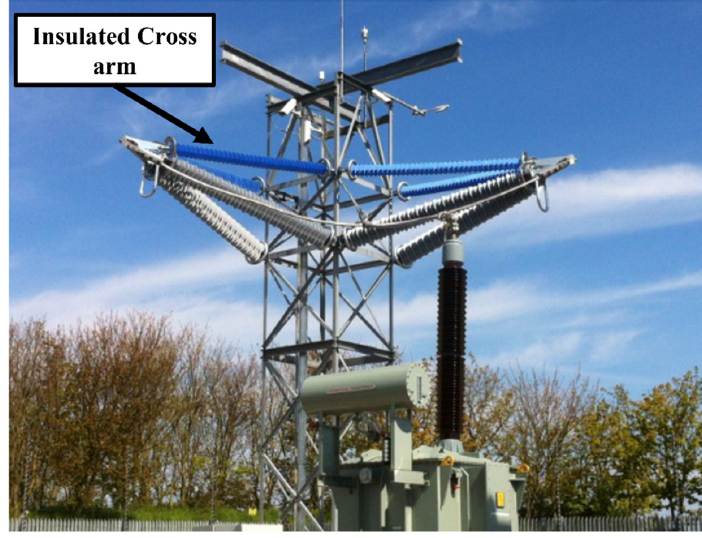
Figure 14. Two insulating cross ‐ arms of 231 kV [36].